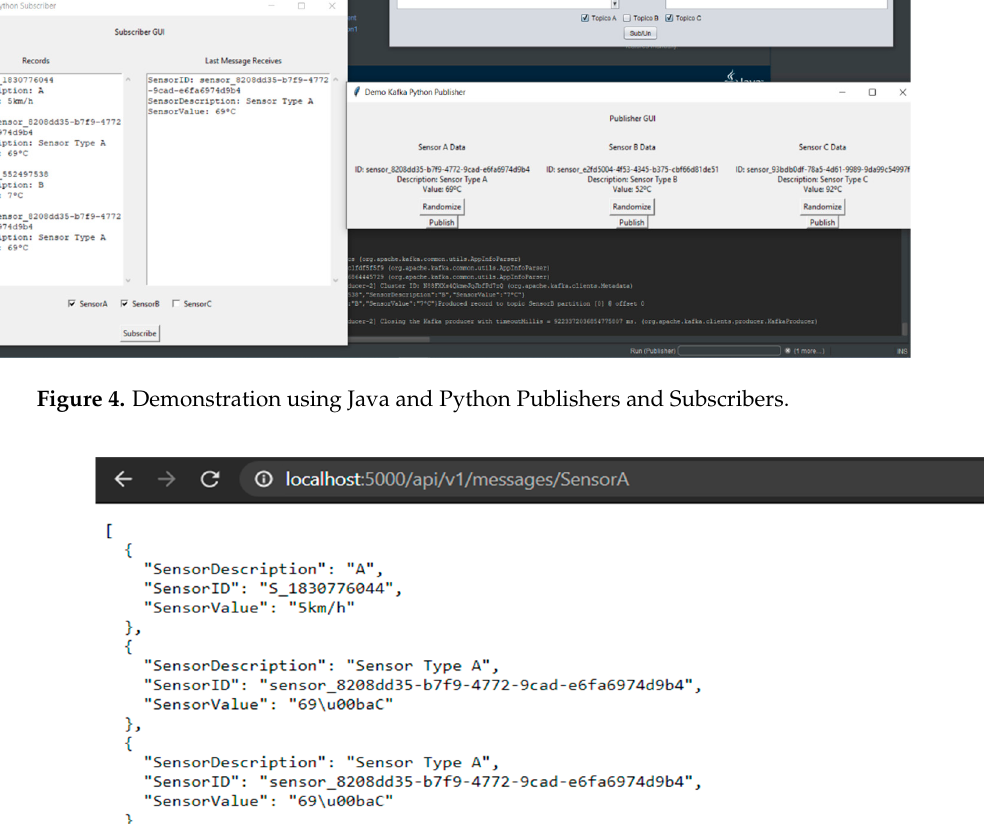
Figure 4. Demonstration using Java and Python Publishers and Subscribers.